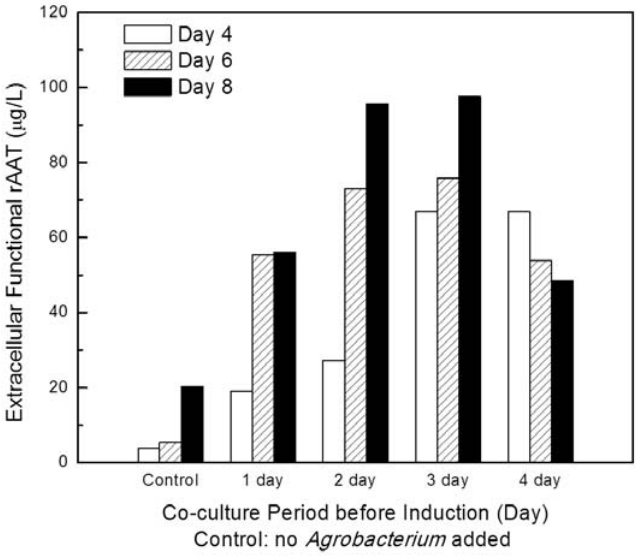
Figure 7. Investigations of the effect of induction timing after starting co ‐ cultivation process on rAAT production. The inducer was added into the co ‐ culture process of Agrobacterium carrying viral gene silencing suppressor P19 with transgenic CMViva on days 1, 2, 3 and 4 after agroinfiltration in a 6 ‐ well microplate at 20 °C. The biomass ratio of Agrobacterium to plant cell was 25 μ g ‐ DCW/g ‐ DCW. Samples were taken on days 4, 6 and 8 post ‐ induction.